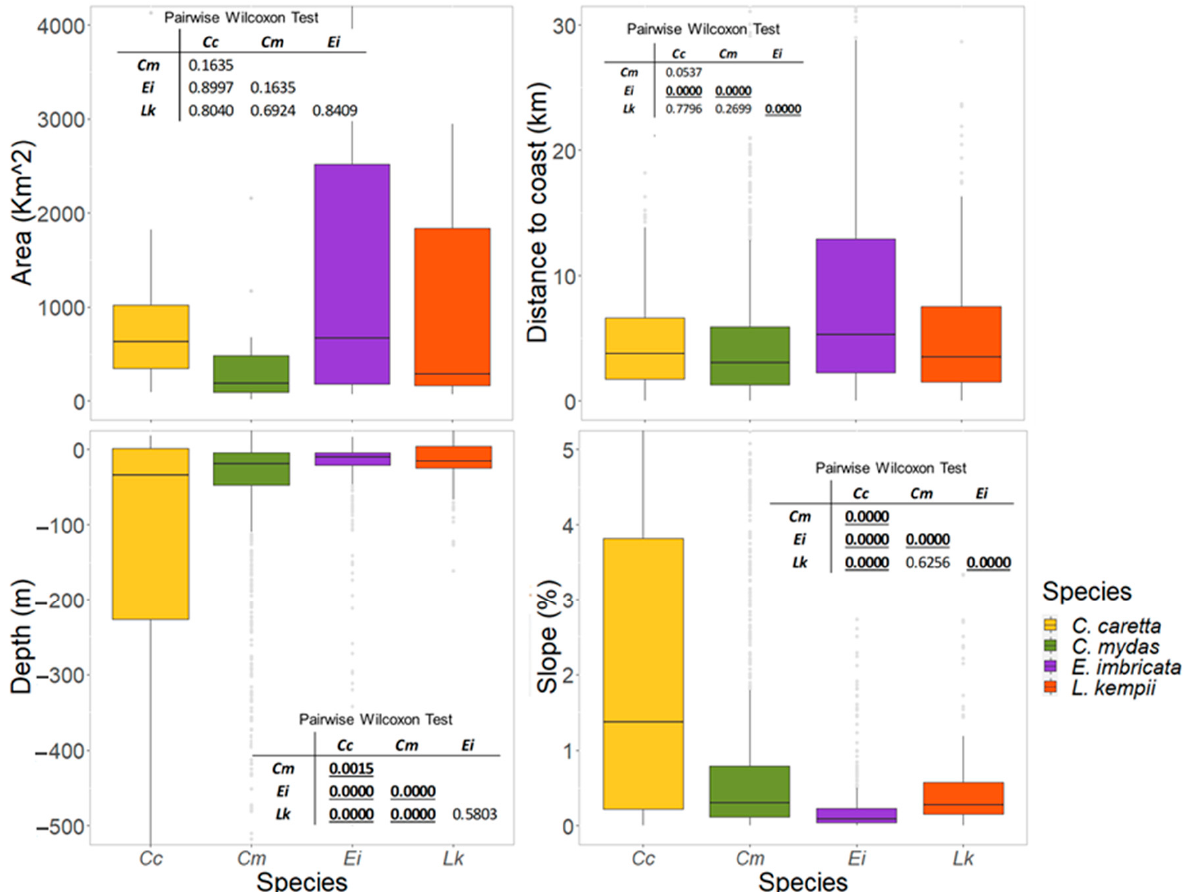
Figure 6. Descriptive statistics and hypothesis test for the physical variables of internesting home ranges of post-nesting sea turtles. A pairwise Wilcoxon Rank Sum hypothesis test is presented as inset table for comparisons between species.